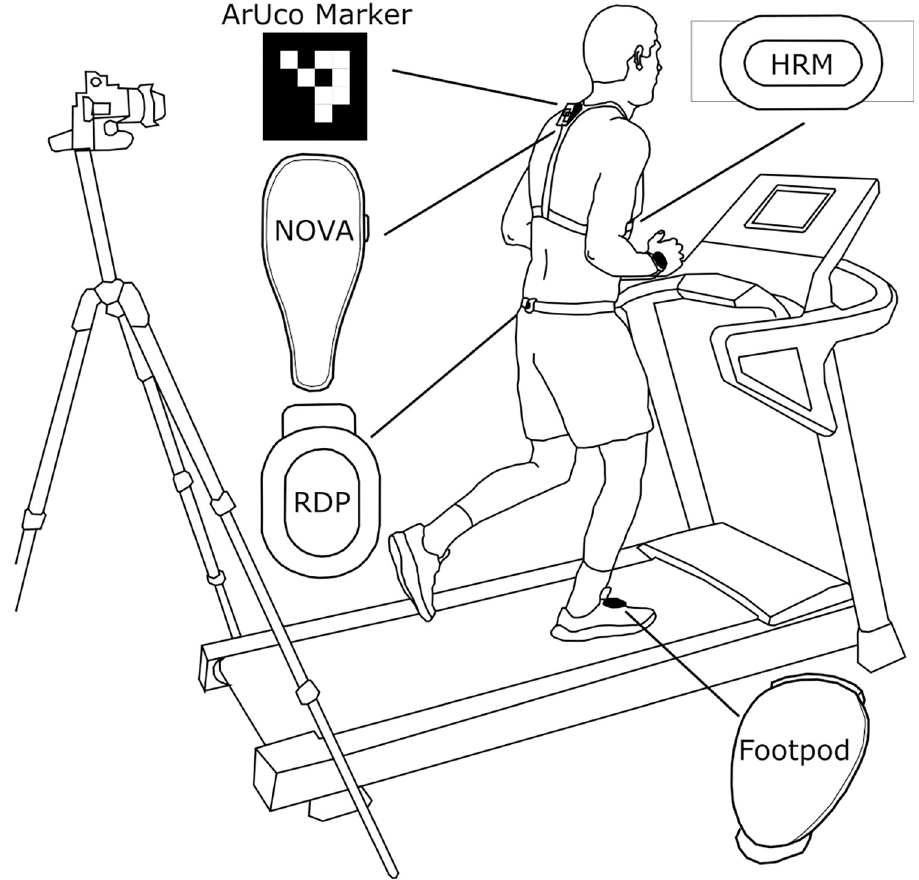
Fig 1. Experimental setup. The illustration shows a participant aboard the treadmill and the positioning of the wearable devices on the body. The INCUS NOVA (NOVA) was worn in a ‘T-Strap’, with the device positioned at C7 vertebrae. The ArUco marker was fixed to the NOVA and video recorded from the rear. The Garmin HRM-Pro chest strap (HRM) was worn with the device positioned at the xiphoid process. The Garmin Running Dynamics Pod (RDP) was clipped to the waistband, aligned with the sagittal plane. The Stryd Running Power Meter Footpod (Footpod) was clipped to the laces of the right trainer. Depictions of the wearable devices are for illustrative purposes only.